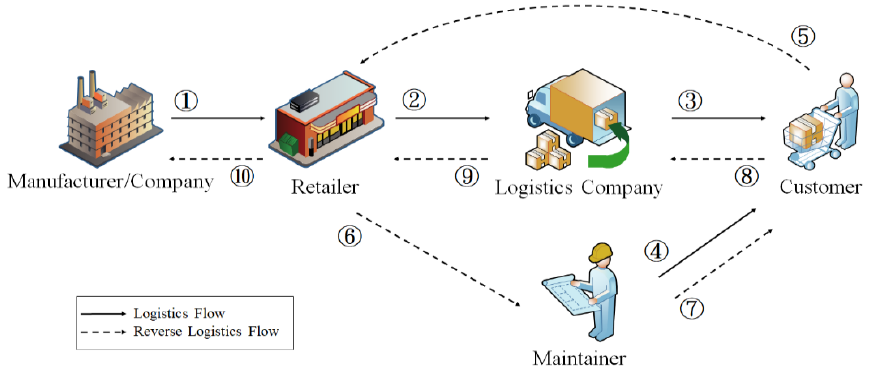
Figure 2. Large home appliances delivery and return scenario.